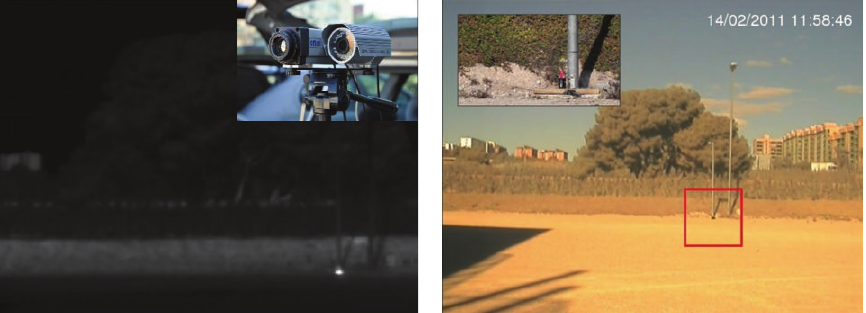
Figure 6: Controlled fire test in real environment.